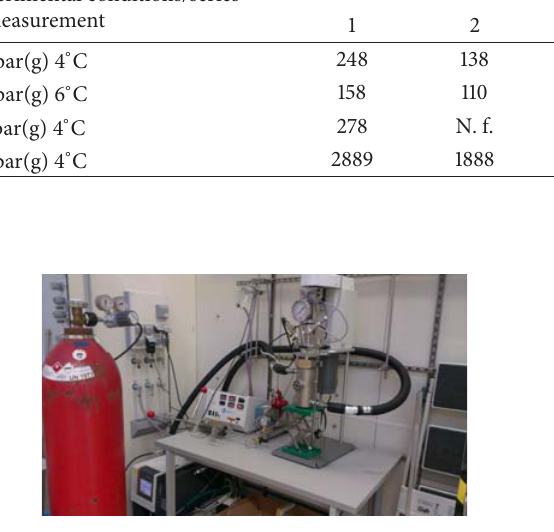
Figure 1: Reactor Parr 4568.